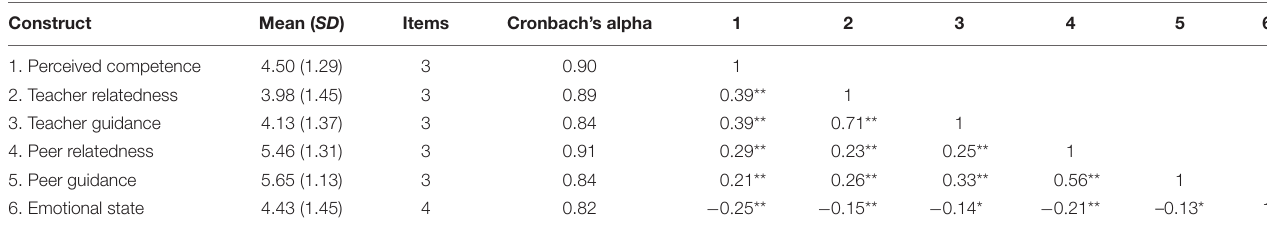
TABLE 3 | The mean, Cronbach’s alpha, and correlation coefficients of the study